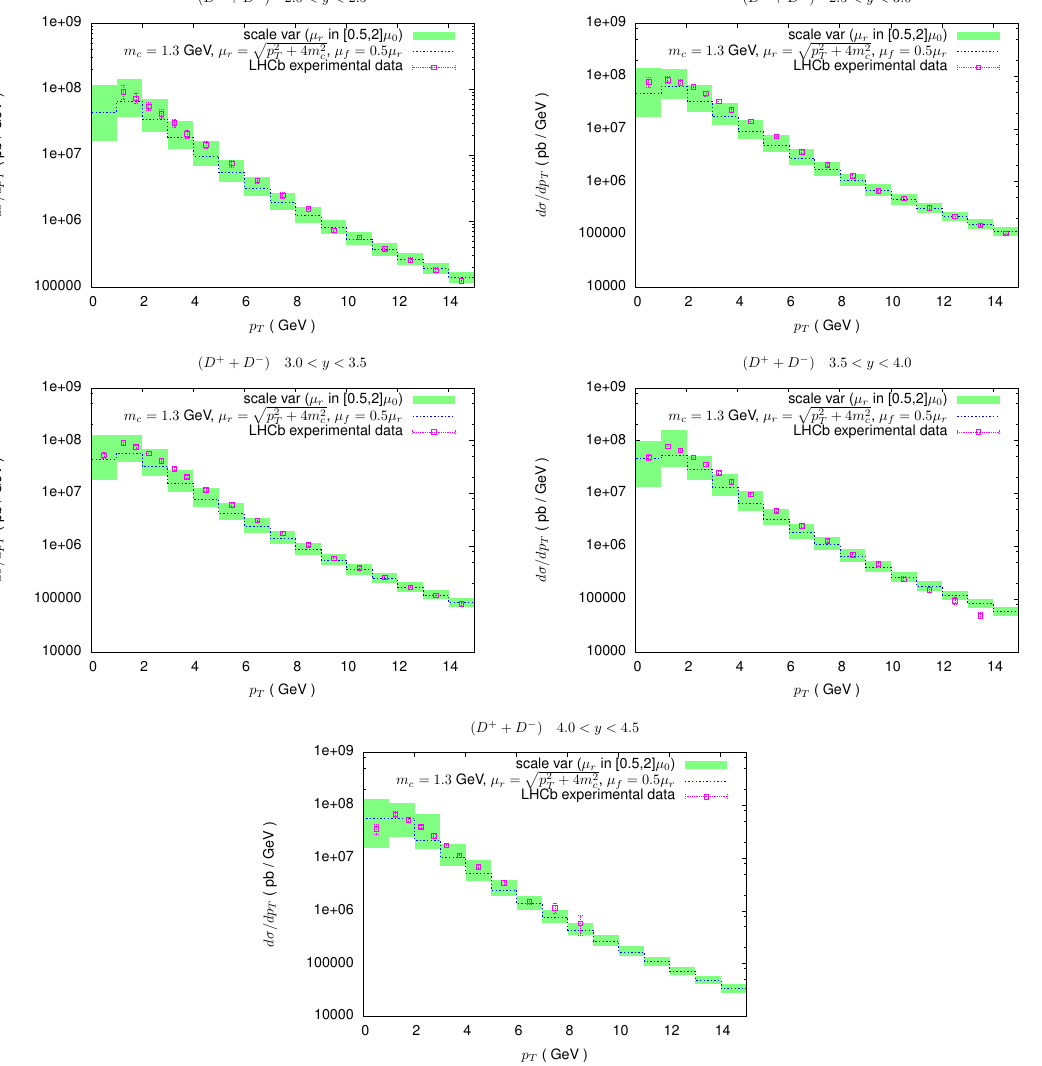
Figure 4 . Our GM-VFNS predictions for ( D + + D (cid:0) ) transverse-momentum distributions for pp collisions at p S = 13 TeV vs. LHCb experimental data of ref. [44]. Each panel corresponds to a di(cid:11)erent rapidity bin in the interval 2 < y < 4.5. The scales are chosen as in (cid:12)gure 2.